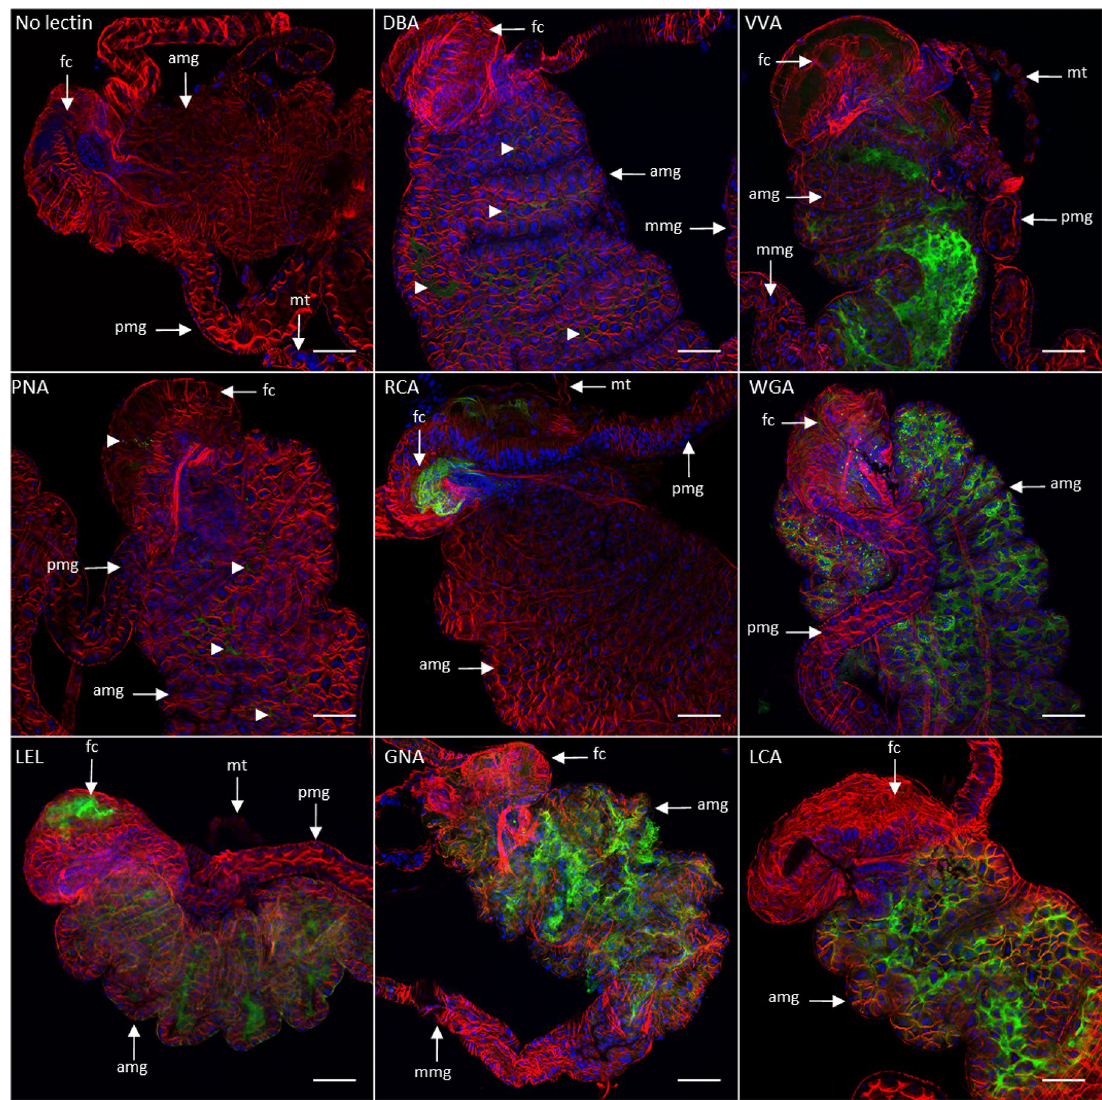
Figure 1. Observation of ingested fluorescent lectins binding midgut carbohydrates of E . variegatus by laser scanning microscopy. Cell nuclei were stained with DAPI (blue), and actin filaments were stained with Alexa 568-phalloidin (red). The FITC-lectins were colored in green. The fluorescent lectins used to stain the cells are indicated in each picture except for the control, where fluorescent lectin was omitted. amg anterior midgut, mmg middle midgut, pmg posterior midgut, fc filter chamber, mt Malpighian tubules. Arrowheads in panels DBA and PNA indicate the presence of fluorescence. Scale bar 100